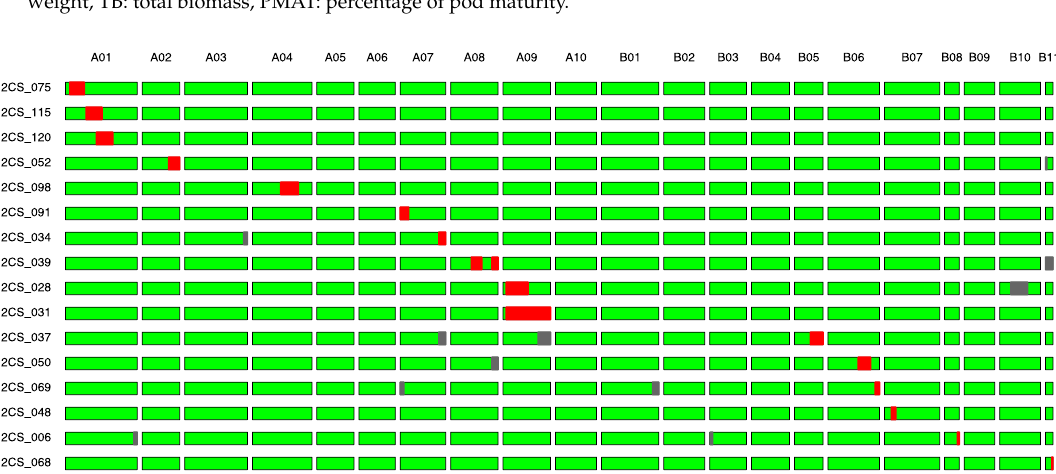
Figure 1. Graphical genotypes of the CSSLs used in this study. The CSSLs are represented in rows and chromosomes are in columns. Green: genetic background of Fleur11. Red: target introgression from the wild species. Grey: non-target wild